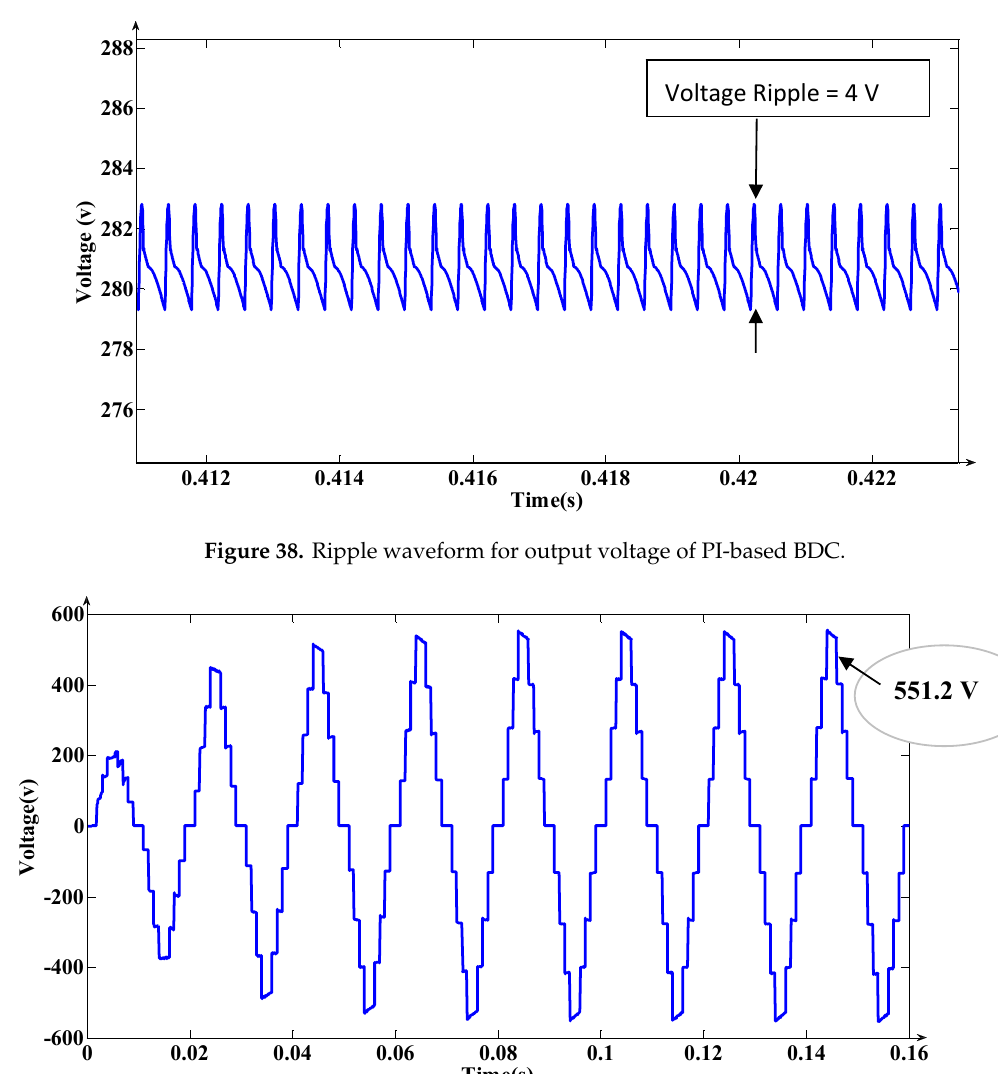
Figure 39. Nine level output voltage waveform for MLI interfaced with PI based BDC.